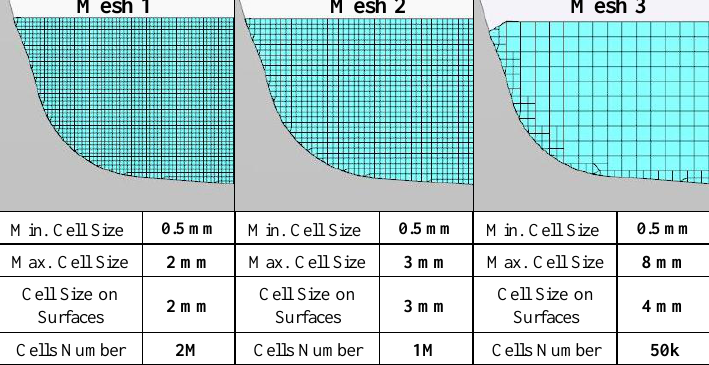
Figure 9. Mesh sensitivity analysis: employed grids.